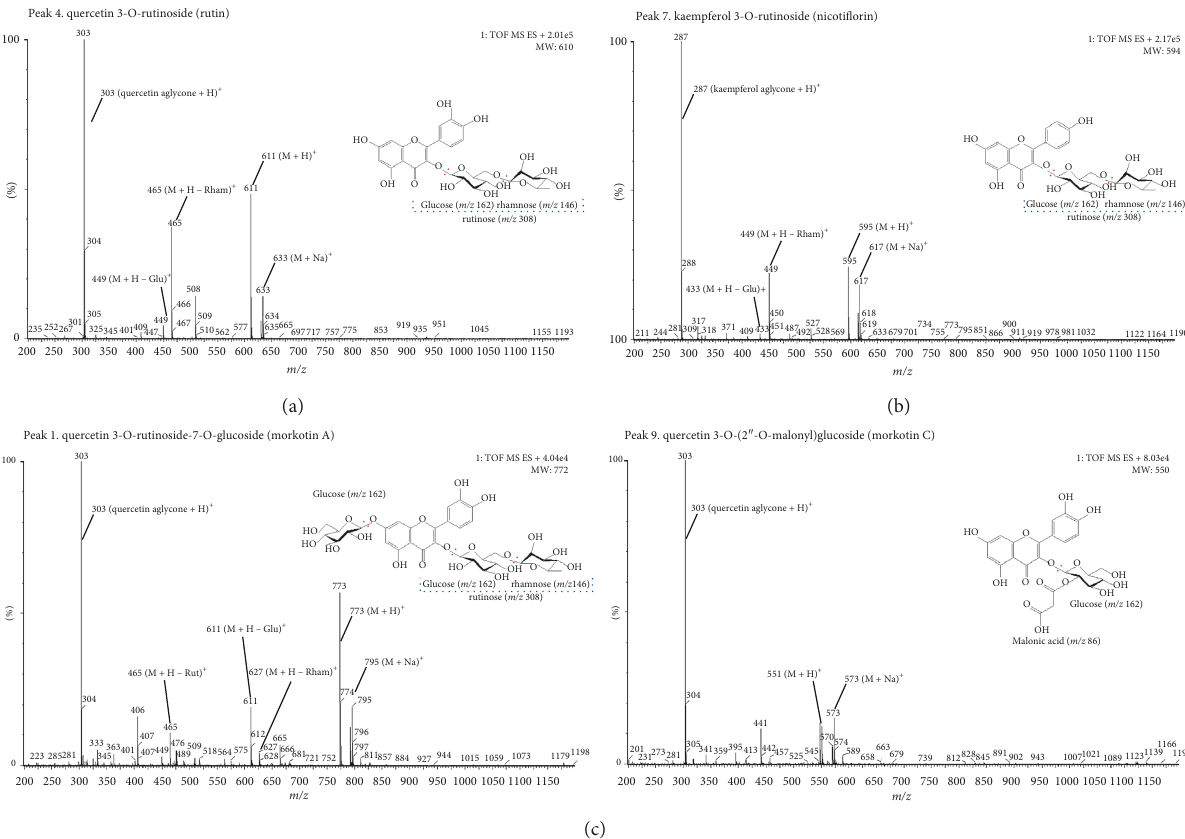
Figure 2: Mass spectra of flavonoids detected in extracts of Korean mulberry fruits. (a) Glycoside derivative of quercetin; (b) glycoside derivative of kaempferol; (c) MS spectra of two new flavonoids detected from extracting Korean mulberry